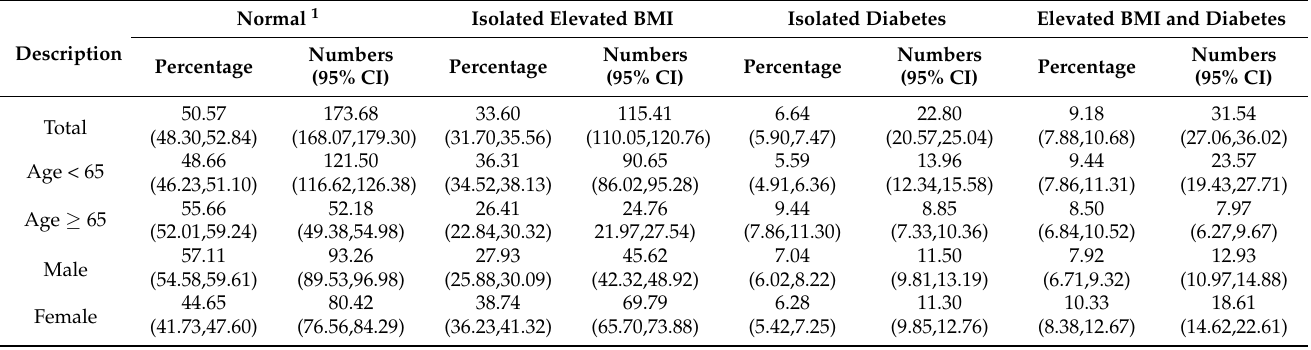
Table 1. Percentage and numbers of Chinese adults who have elevated BMI 2 , diabetes 3 , or both.